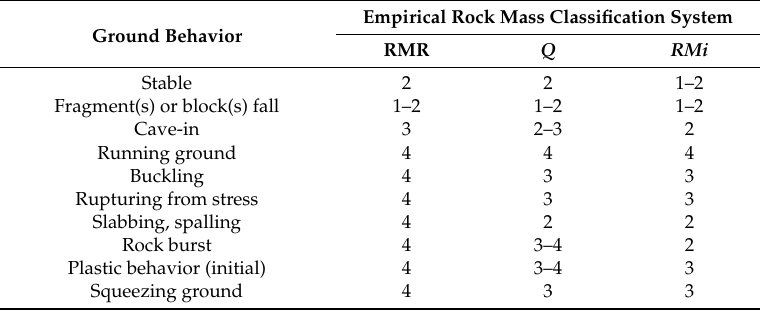
Table 1. The fitness of empirical rock mass classification systems for different ground behaviors